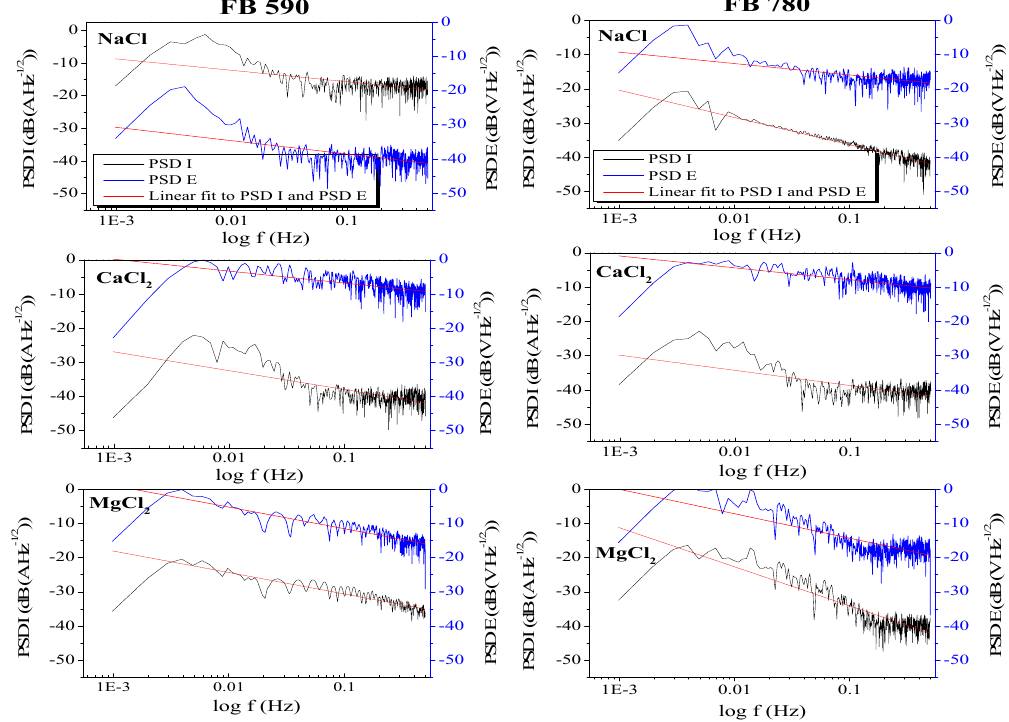
Figure 8. EN data in frequency domains for FB steels exposed in NaCl, CaCl 2 and MgCl 2 solutions.